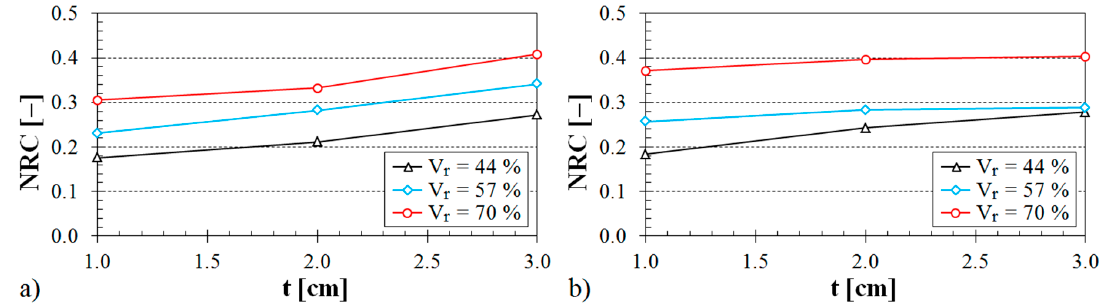
Figure 13. Influence of the volume ratio on the noise reduction coefficient vs. material thickness for the investigated ABS samples: ( a ) Octagonal structure, air space size a = 12 cm; ( b ) Starlit structure, air space size a = 4 cm.